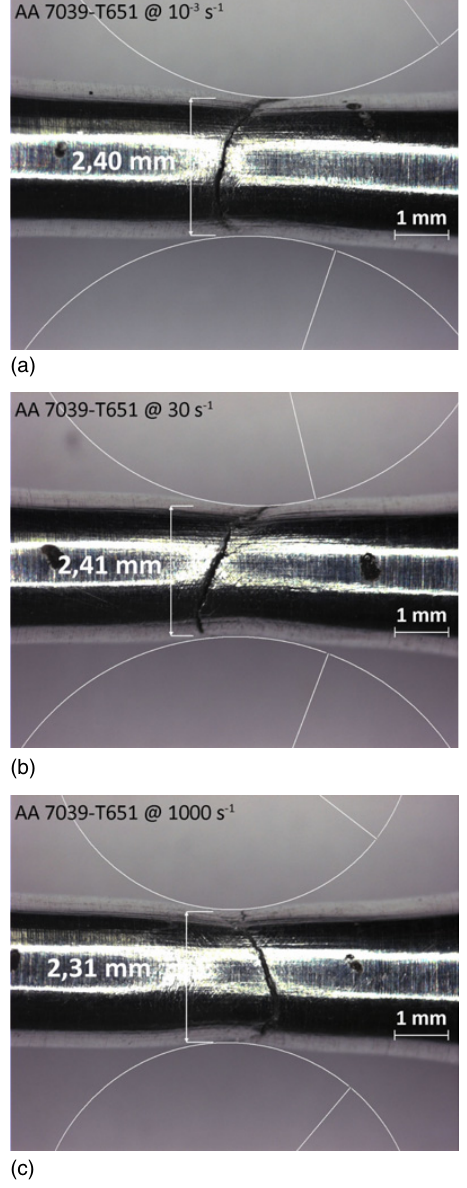
Fig. 11. (a) Sample AA 5059-H131 (#01) @ 0 , 001s − 1 . (b) Sample AA 5059-H131 (#09) @ 30s − 1 . (c) Sample AA 5059- H131 (#03) @ 1000s − 1 .